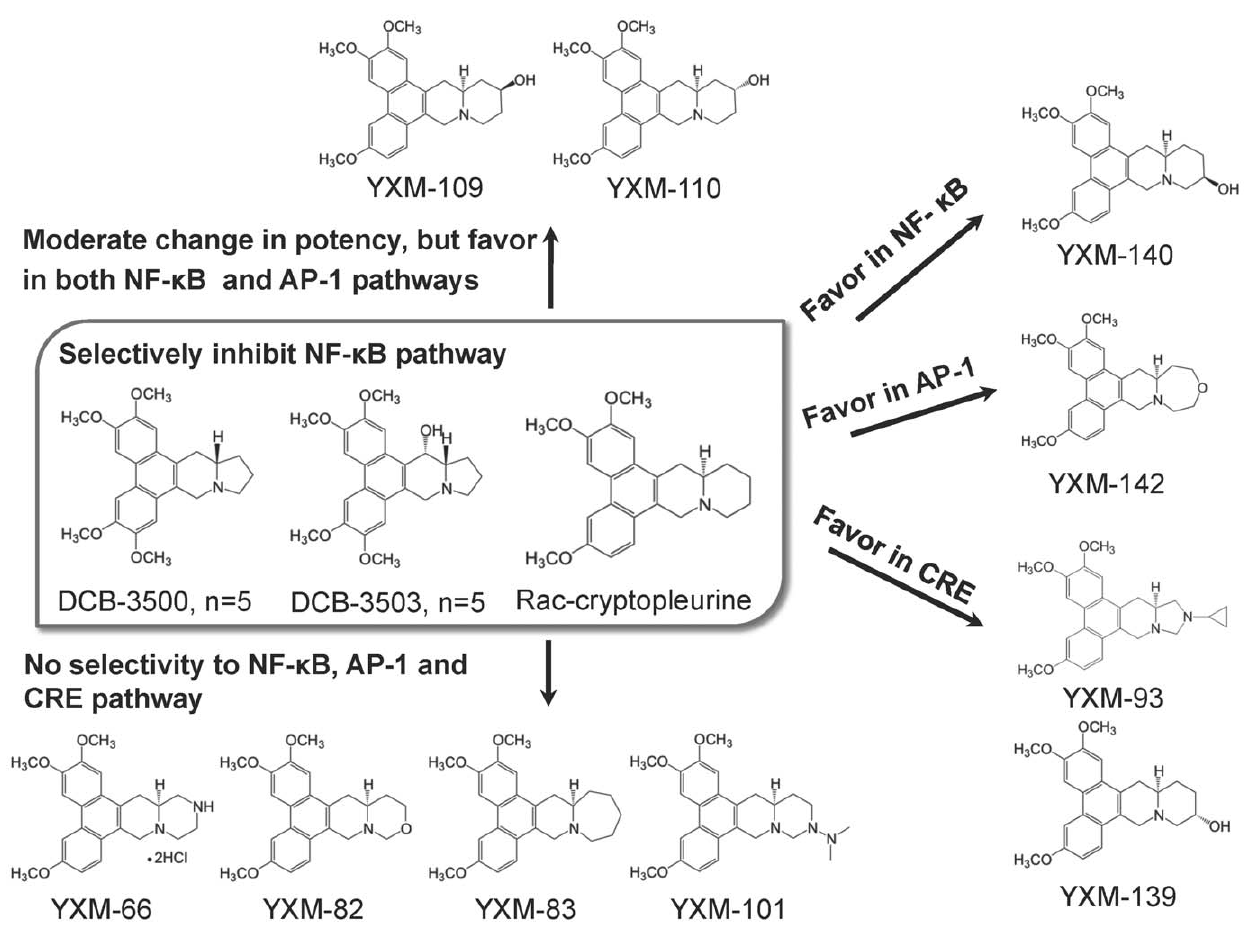
Figure 6. Schematic description of the SAR of cryptopleurine analogs with modification on the E-ring in HepG2 cell line.